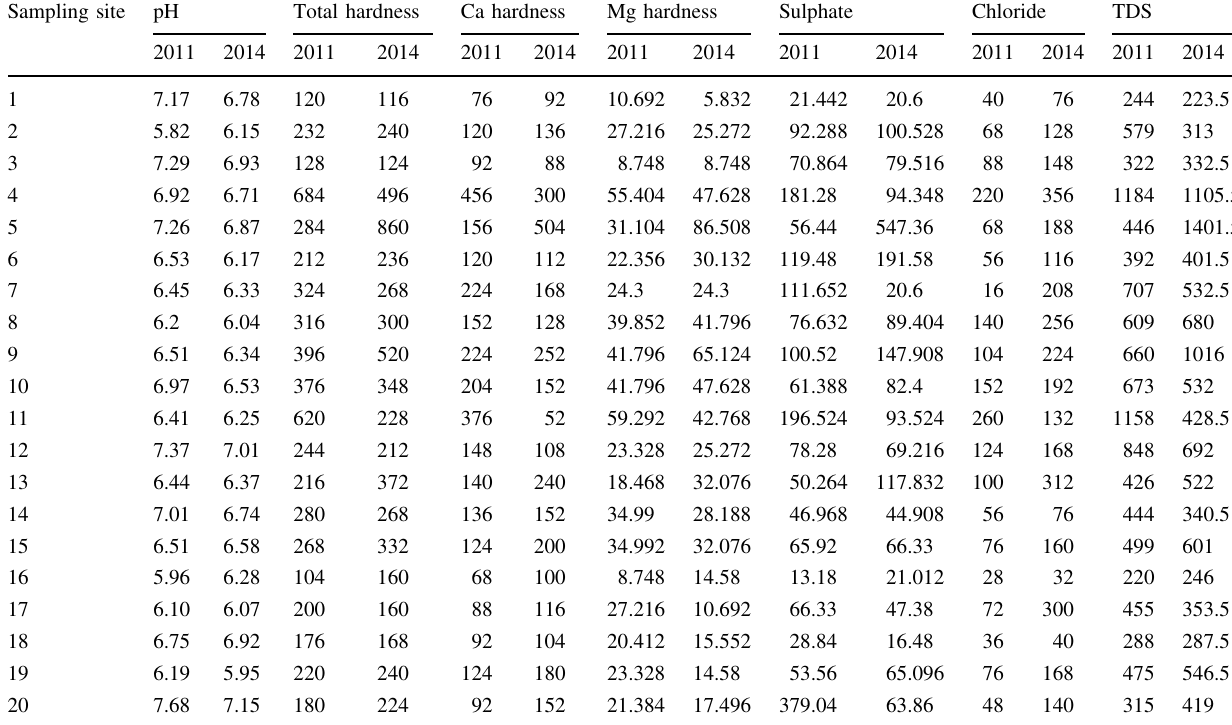
Table 1 Analysis of different parameters of groundwater in lean period of years 2011 and 2014 (in mg/l except pH) Sampling